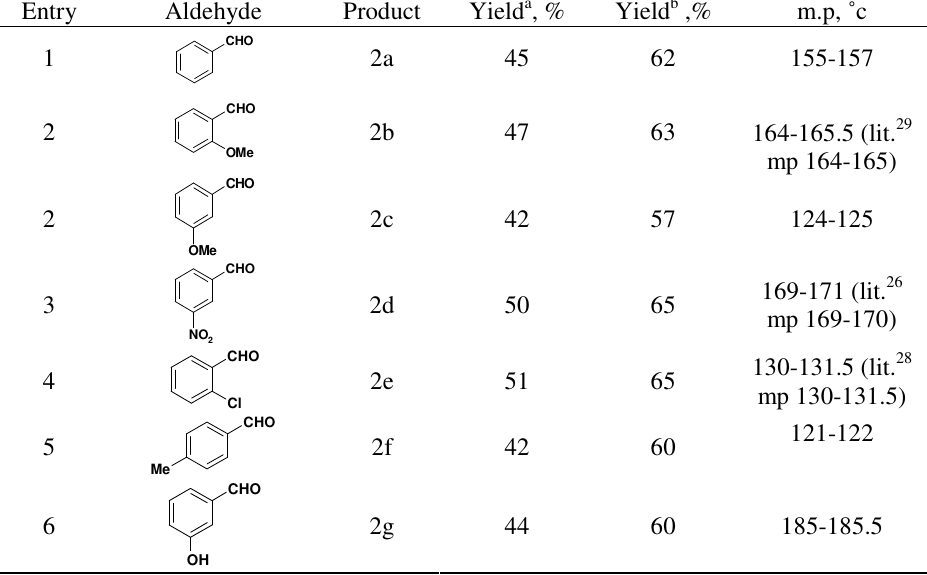
Table 1. Synthesis of 1,4-dihydropyridine derivatives in water under reflux conditions